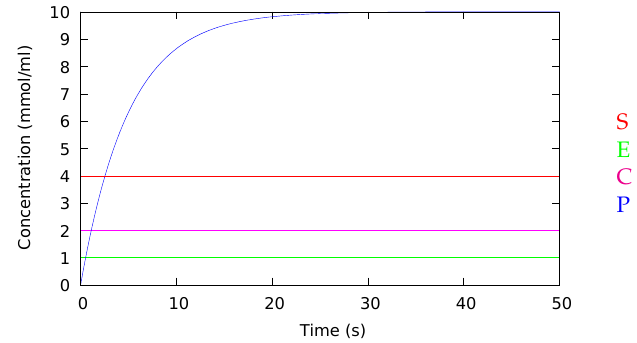
Figure 1. Evolution of the concentration of S , E , C and P in enzymatic network with mass-action kinetics with the parameters k 1 = k 2 = k 3 = 1, the initial concentrations E ( 0 ) = 1, C ( 0 ) = 2, S ( 0 ) = 4, k 4 −→ P ( 0 ) = 0, and in the context of the network with a reaction ∅ S which produces S with constant k 5 P −−→ ∅ speed k 4 = 2, and a reaction P which degrades P with parameter k 5 =